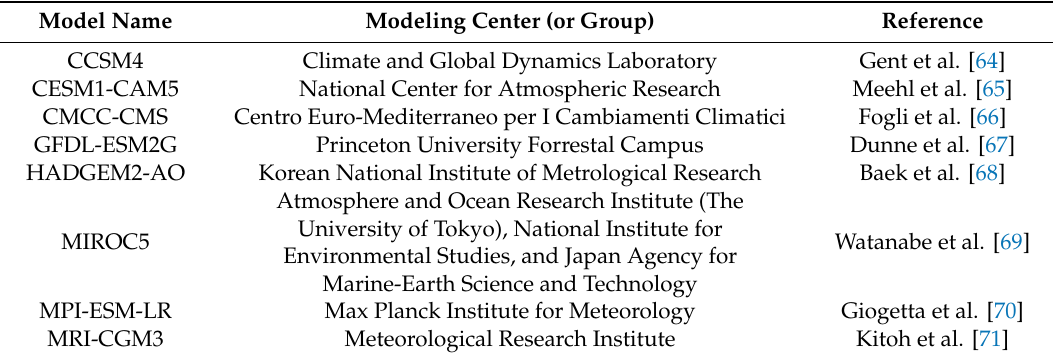
Table 1. Global circulation models (GCMs) considered in this